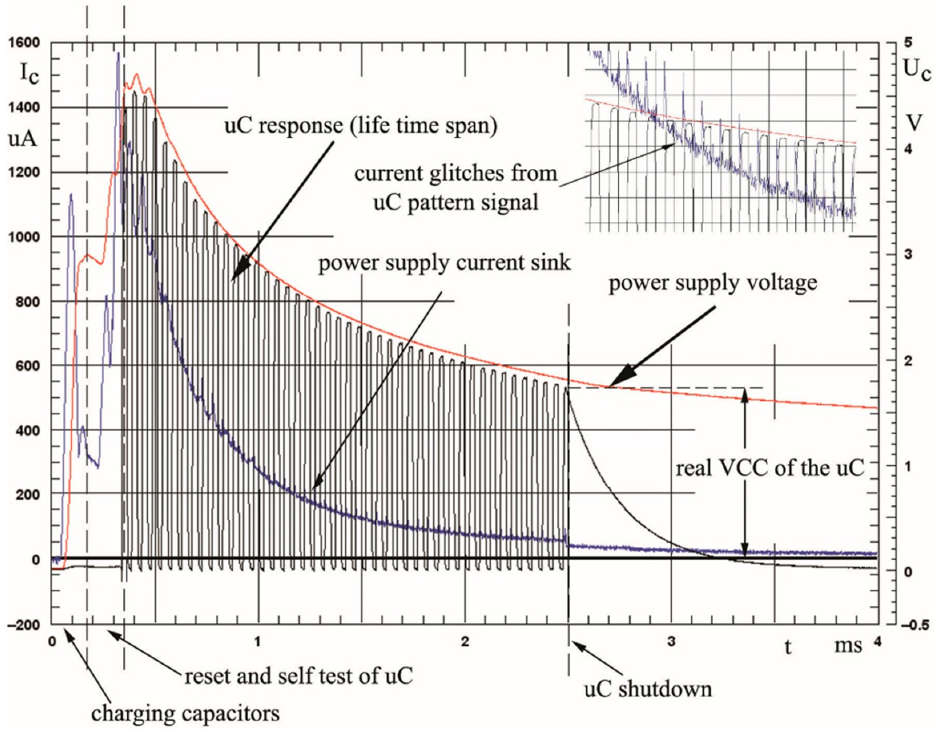
Figure 10. The lifetime of the ATMEGA48V microcontroller circuit powered by the DTCCM harvesting device at a low impact energy of E k = 0.25 J.